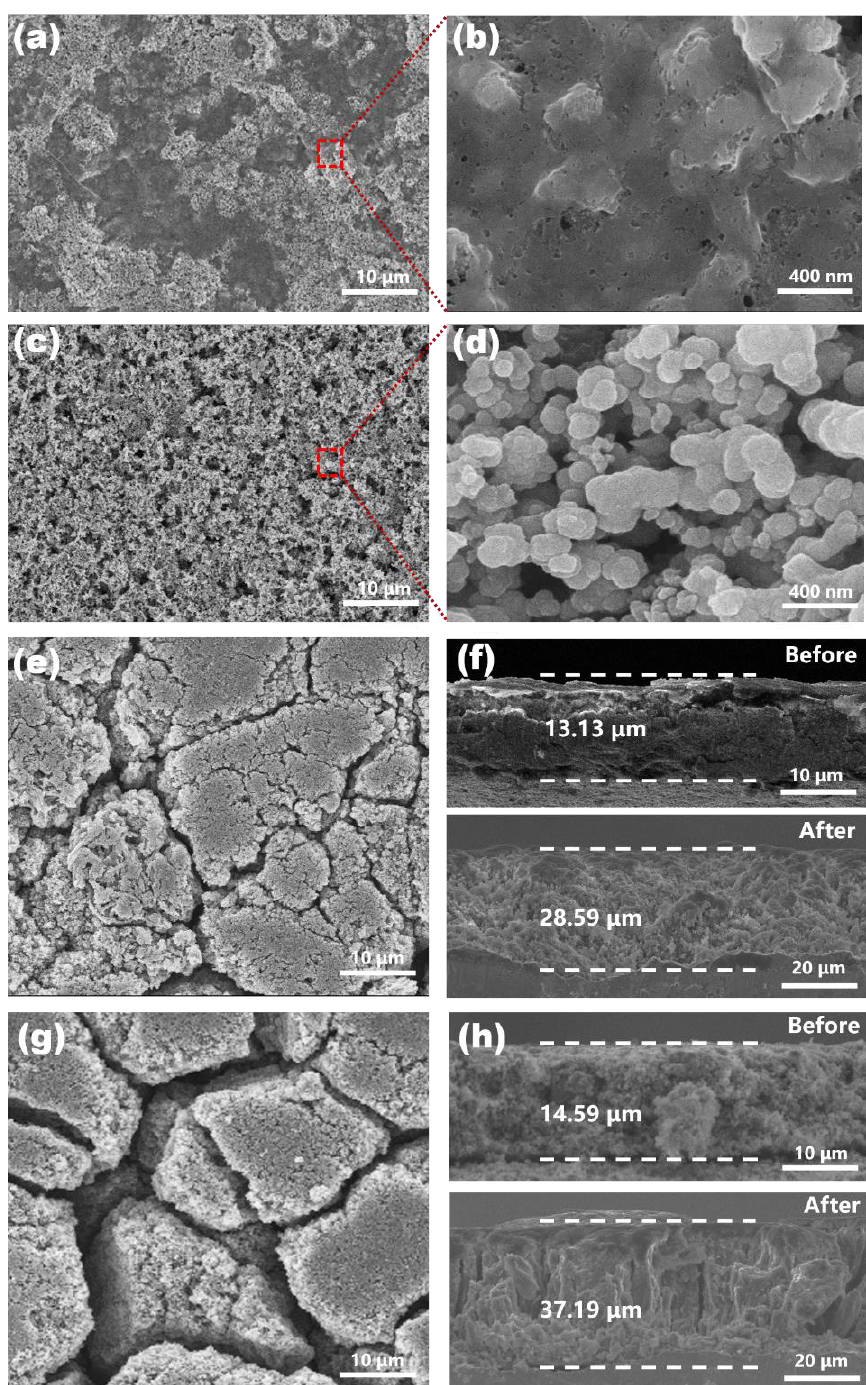
Figure 4. SEM characterization of the electrodes before and after cycling. ( a , b ) Top−view SEM images of PAA−PED−Si electrode before cycling (( b ) is the amplified image of red box area in ( a ), the same below); ( c , d ) top−view SEM images of PAA−CB−Si electrode before cycling; ( e ) top−view SEM images of PAA−PED−Si after the 100th delithiation; ( f ) cross−sectional images of PAA−PED−Si before and after the 100th delithiation; ( g ) top−view SEM images of PAA−CB−Si after the 100th delithiation; ( h ) cross−sectional images of PAA−CB−Si before and after the 100th delithiation.